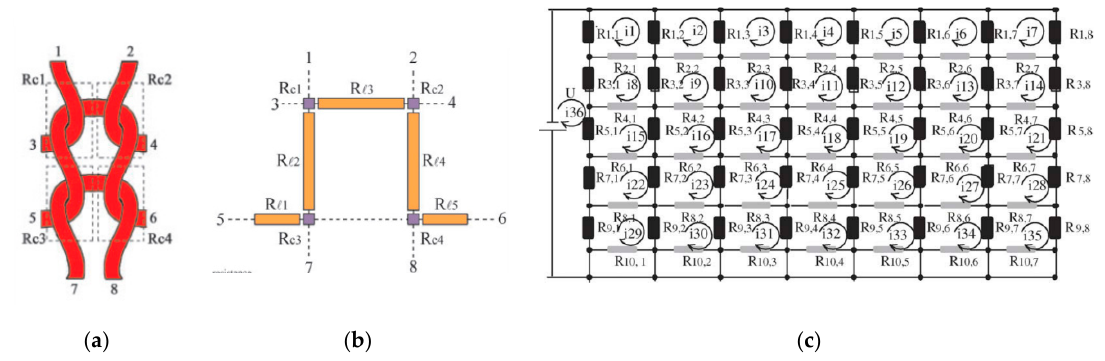
Figure 17. ( a , b ) Unit cell of knit [68]; ( c ) Resistor network approach [53].